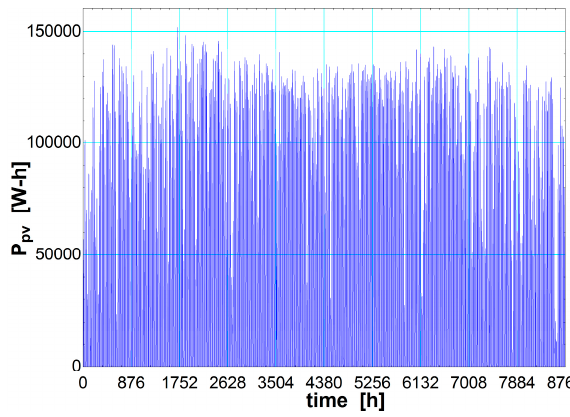
Figure 4. Generation of electrical energy in the photovoltaic subsystem throughout the year.